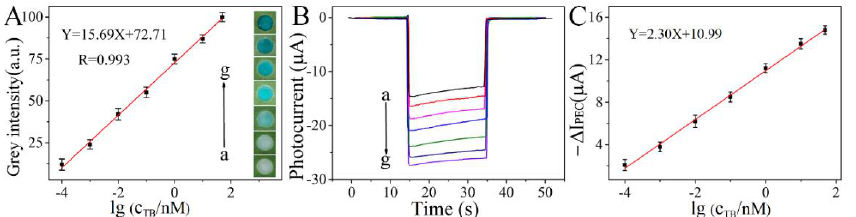
Figure 6. ( A ) Calibration curve between color intensity and logarithm of TB concentration (inset: color intensity). ( B ) Photocurrent of sensing device at different TB concentrations (0.0001, 0.001, 0.01, 0.1, 1, 10, 50 nM) and ( C ) corresponding calibration curve between −ΔI PEC and logarithm of TB concentration. Table 1. Comparison of the biosensor with other analytical strategies.